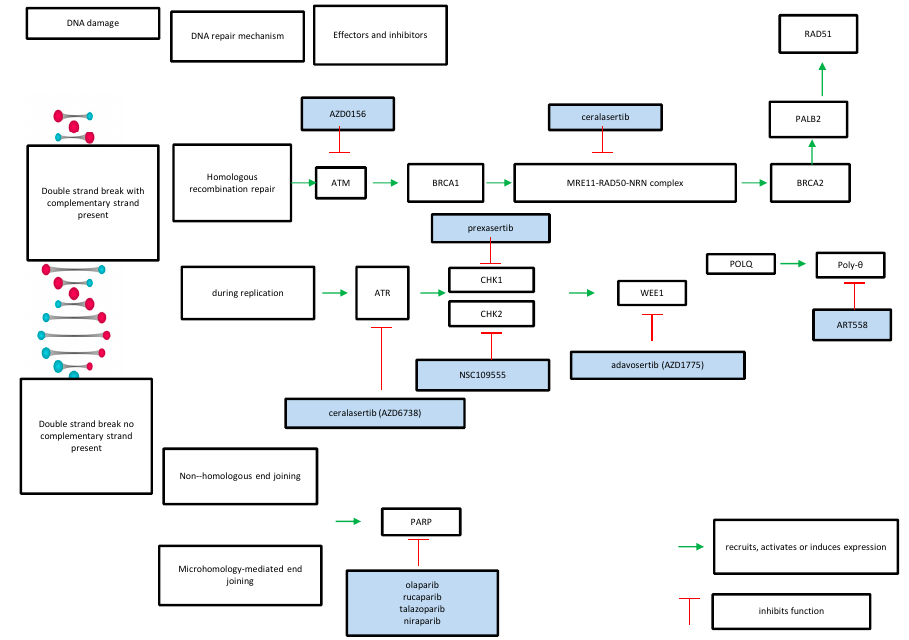
Figure 1. Schematic representation of the repair pathways of double-strand DNA damage and inhibitors discussed in this article.